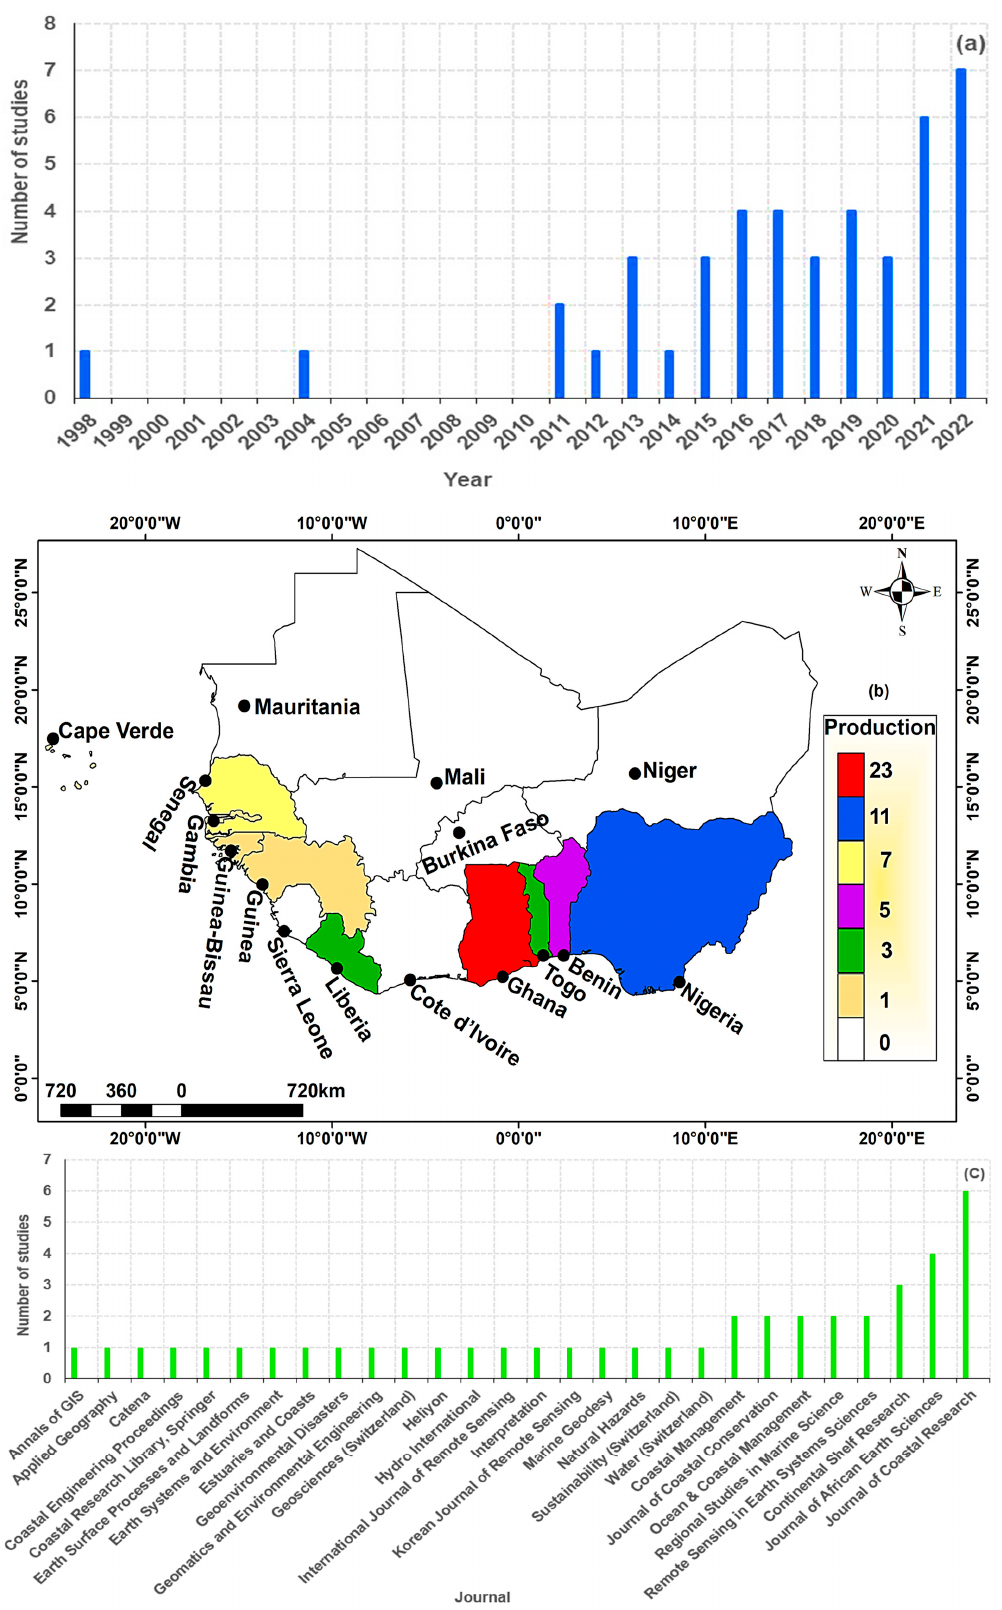
Figure 3. Publication characteristics ( a ), country production ( b ), and journals for research dissemina- tion ( c ) for shoreline change and coastal erosion analysis in West Africa. Note: The year 2022 extends up to the month of October.